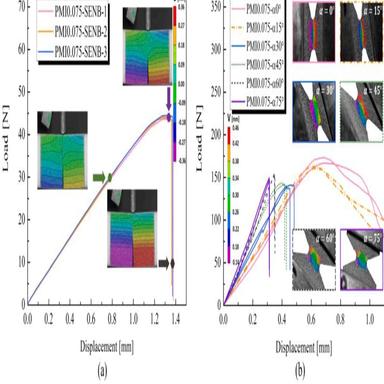
The load-displacement responses of pre-cracked specimens of PMI foam material (density: 0.075 g/cm3 ) under (a) single edge notch bend (SENB) and (b) combined tension-shear loading. The SENB tests produced the mode I fracture and combined tension-shear tests produced the mode II as well as mixedmode fractures.